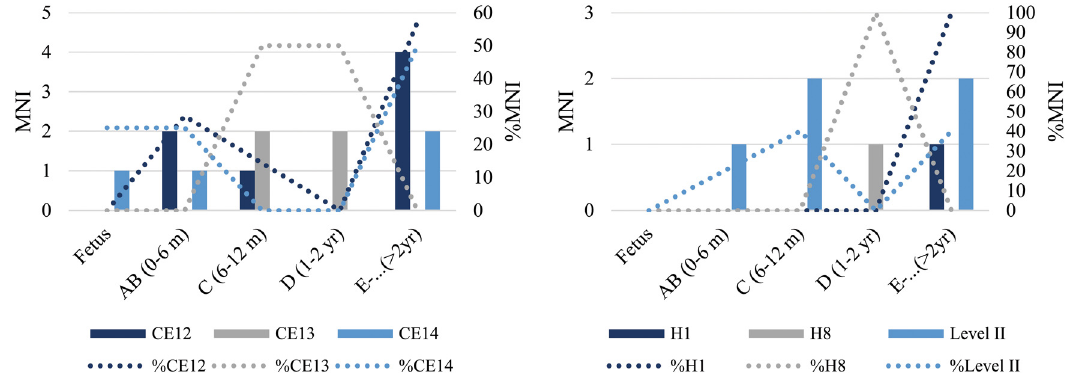
Figure 6: Mortality pro fi les of domestic caprines recovered in sectors CE and CV. The classi fi cation is based on the age categories of Payne ( 1973 )